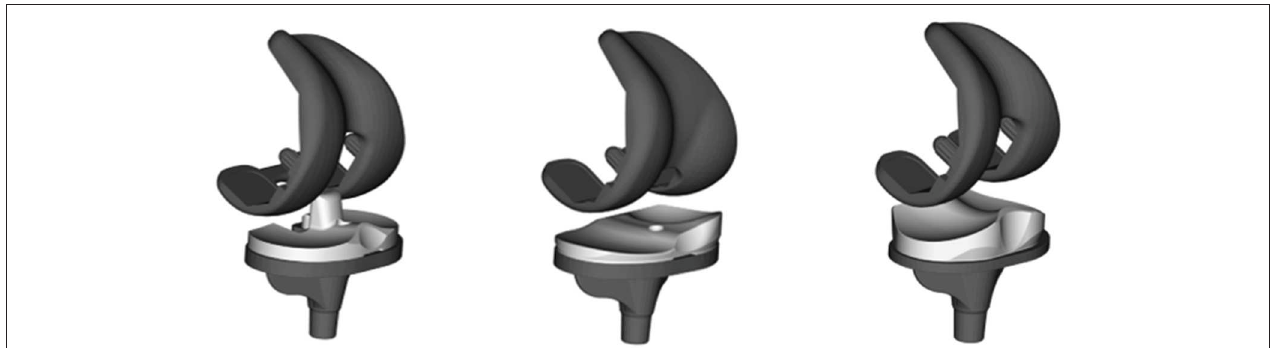
FIGURE 1 | Three implant designs were investigated in this study: GMK Primary posterior stabilized (left) , GMK Sphere (middle) , and GMK Primary ultra-congruent design (right)